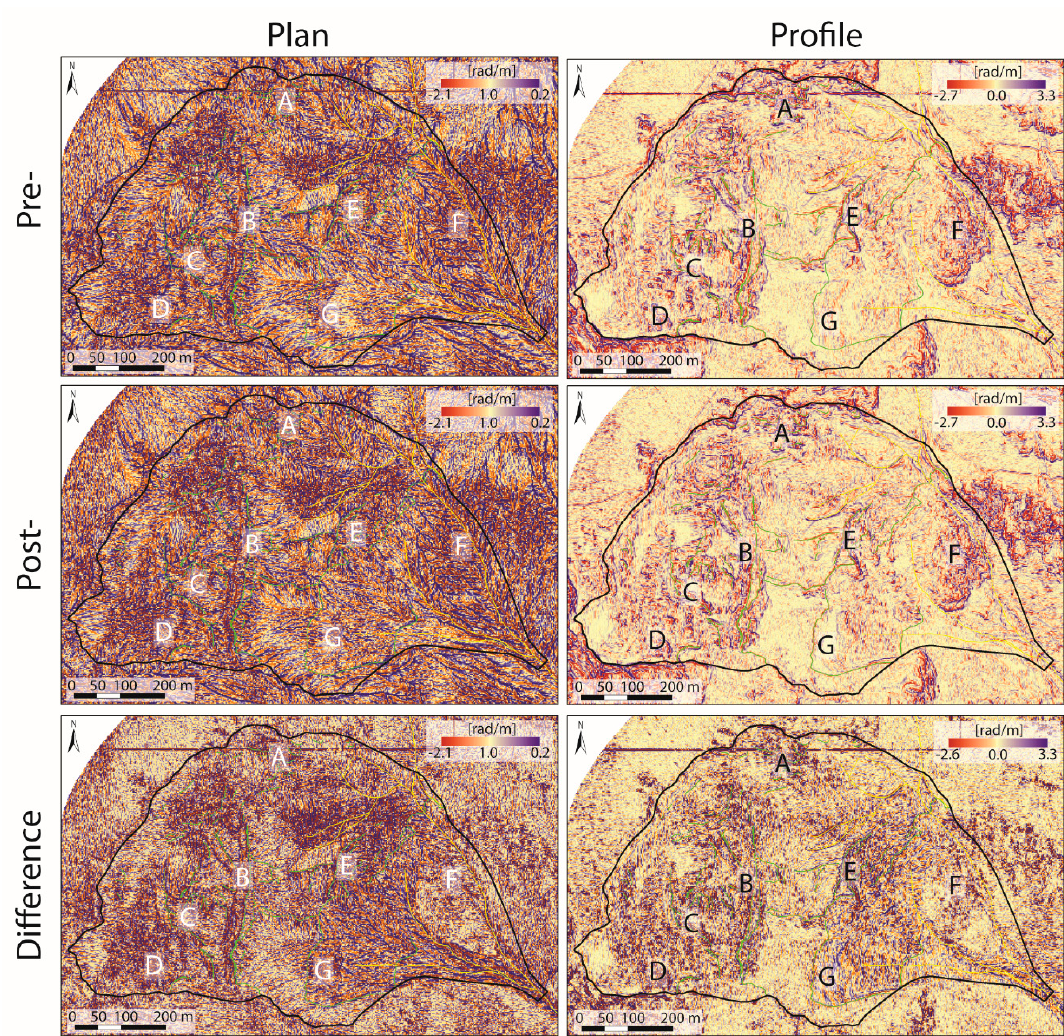
Figure 10. Pre- and post-plans and profiles, curvatures, and their differences. A–G localize the areas affected by the main morphological changes. The light green lines highlight the gravity-related forms (e.g., minor crowns, lithostructural and morphological scarps, counterscarps, crests, and trenches), and the yellow lines show the creek and artificial channels.